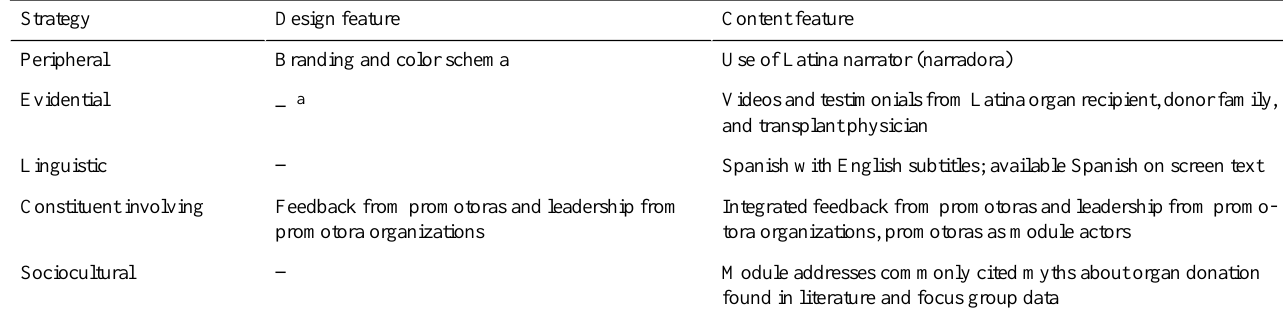
Table 2. Strategies for achieving cultural and linguistic